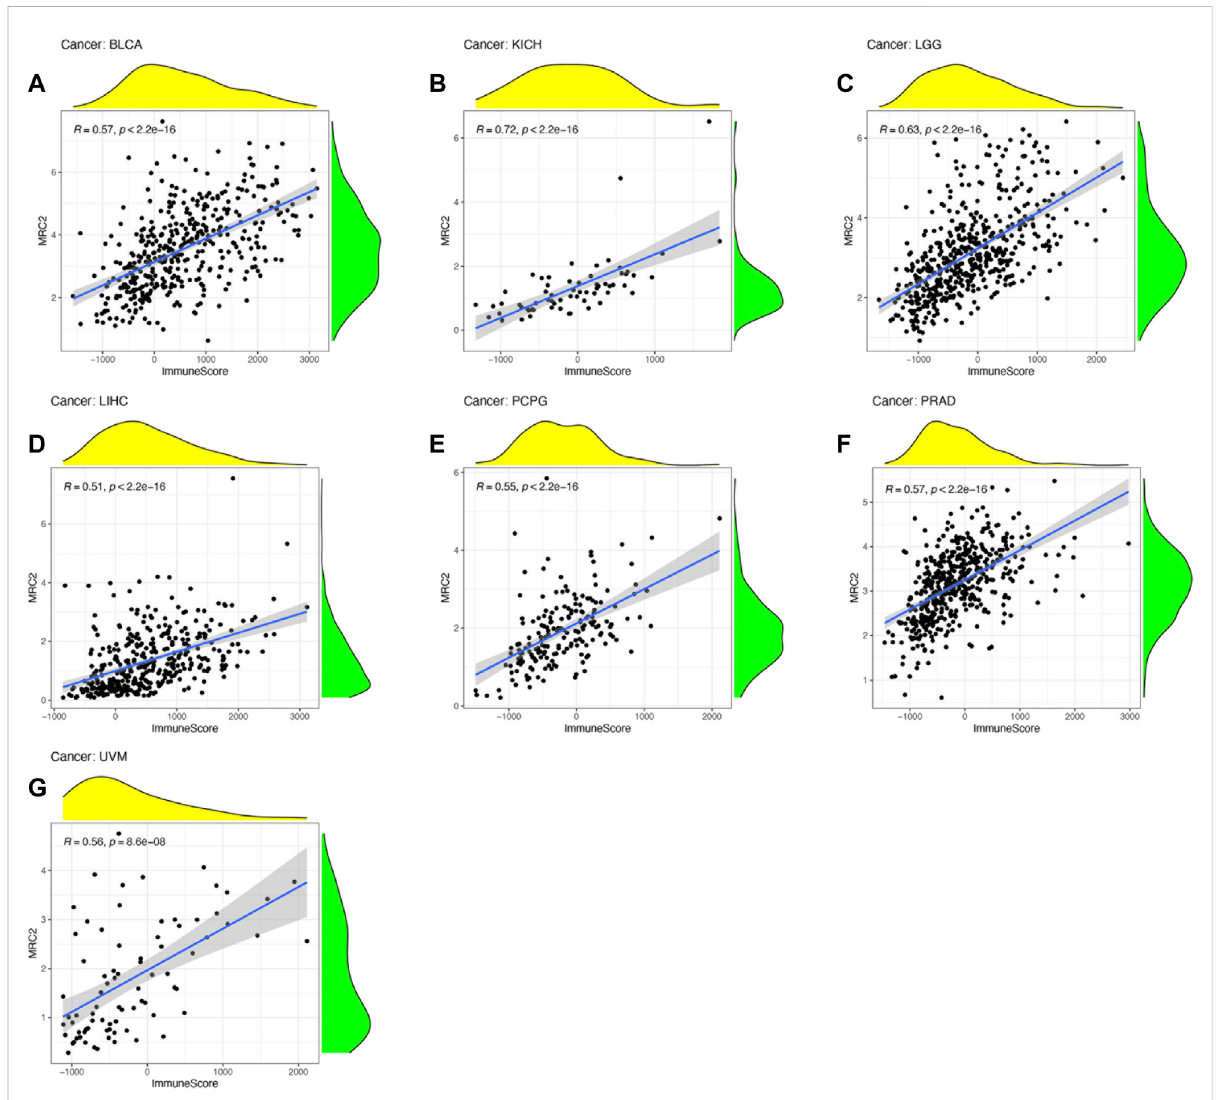
FIGURE 4 The correlation of MRC2 expression with Immune Score. The correlation fi lter was set as p < 0.001 and |R| > 0.5 (A – G)